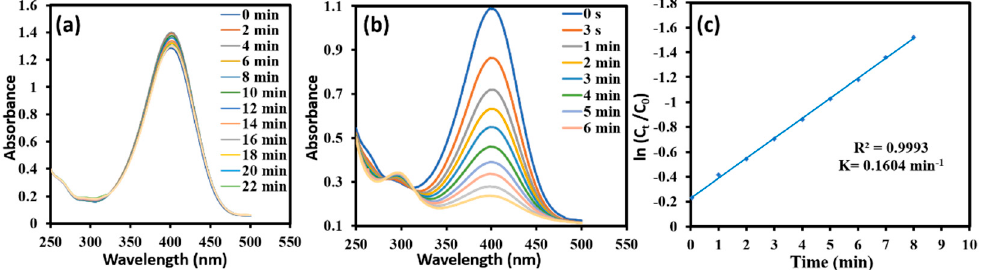
Figure 6. UV-vis spectrum of ( a ) 4-NP with NaBH 4 showing no reduction with time, ( b ) catalytic reduction of 4-NP with NaBH 4 by AgNPs, and ( c ) a plot of ln (C t /C 0 ) against time on catalytic reduc- tion of 4-NP.